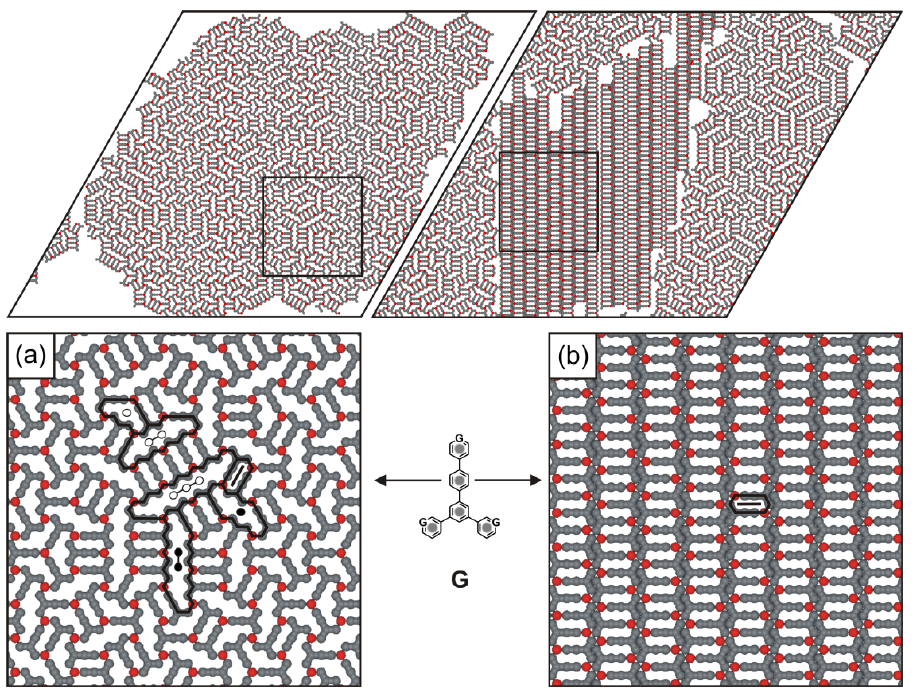
Figure 8. ( a ) The aperiodic metal–organic network comprising 1200 metal atoms and 1200 anchor-like ligands G in a 1:1 stoichiometric ratio at surface coverage θ ∼ 0.42, T = 0.001; ( b ) adsorbed overlayer composed of 1500 metal atoms and 1500 molecules ligands G in a 1:1 stoichiometric ratio at surface coverage θ ∼ 0.53, T = 0.001. The solid black lines mark the edges of empty nanopores differing in size and shape.